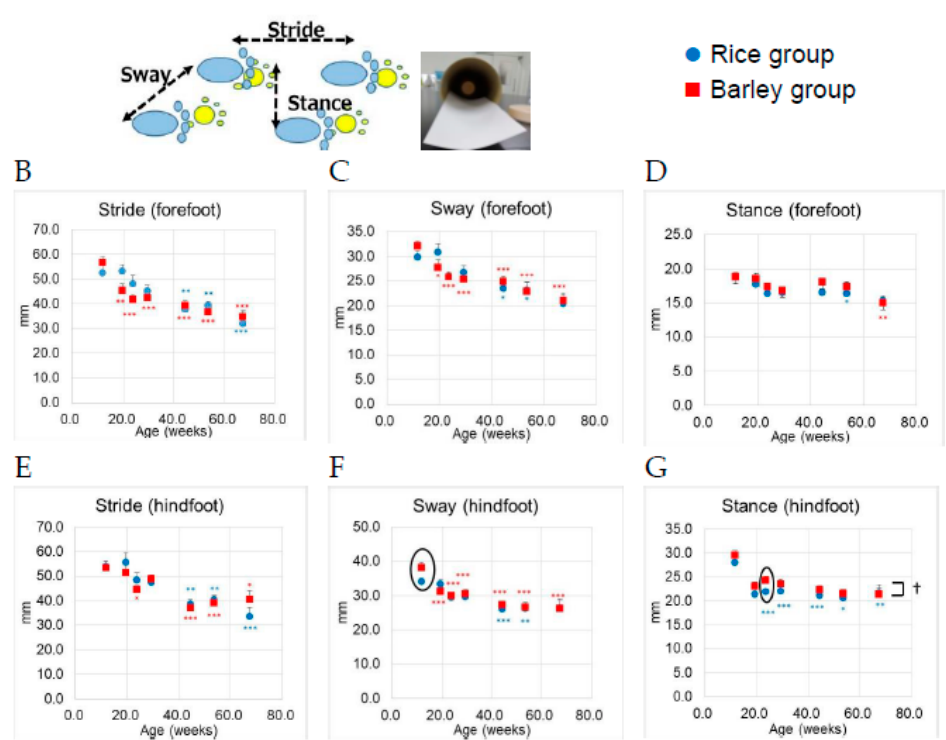
Figure 7. Changes of parameters in the foot print test in SAMP8 mice consuming rice or barley diets during the lifespan: ( A ) Measurement of six points in the foot print test (sway, stride, and stance in forefoot and hindfoot); ( B ) stride of forefoot; ( C ) sway of forefoot; ( D ) stance of forefoot; ( E ) stride of hindfoot; ( F ) sway of hindfoot; ( G ) stance of hindfoot. By two-way ANOVA, † p < 0.05; group. The circle surrounding the symbols indicate a significant difference between groups by unpaired t -test (p < 0.05). * p < 0.05; ** p < 0.01; *** p < 0.01 (blue color; Rice group, red color; Barley group); within group comparison by Dunnett test vs. 12 weeks old.